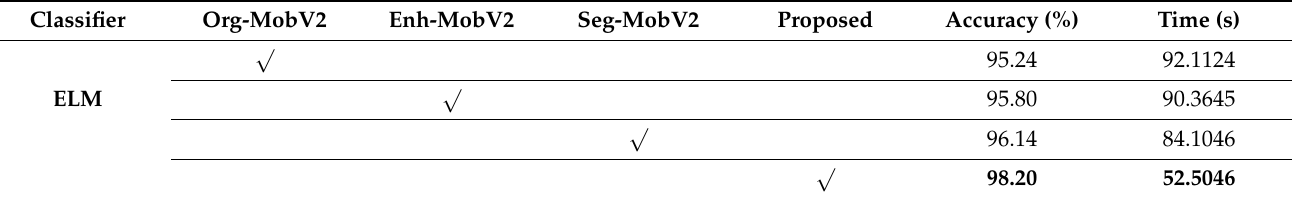
Table 2. Proposed framework classification results on Kvasir V1 dataset .